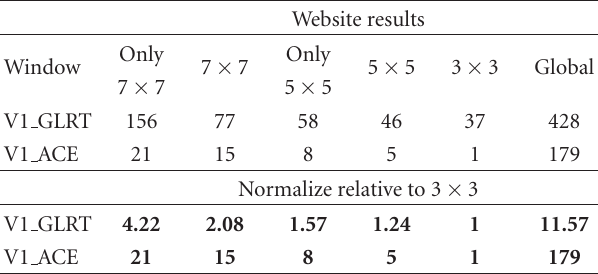
Table 6: RIT results for the actual detection of V1 in RIT test image are shown in the first two lines. The percentage of implanted target was 0.75%. The GLRT and ACE algorithms were calculated as presented in the text. The size of the background was calculated for 3 × 3, 5 × 5 and 7 × 7 frames, excluding the center pixel. The “Only” 7 × 7 and 5 × 5 algorithms only used the outer ring of the window. The third and fourth lines represent the same results normalized by dividing by the values obtained by the 3 × 3 filter. Website results